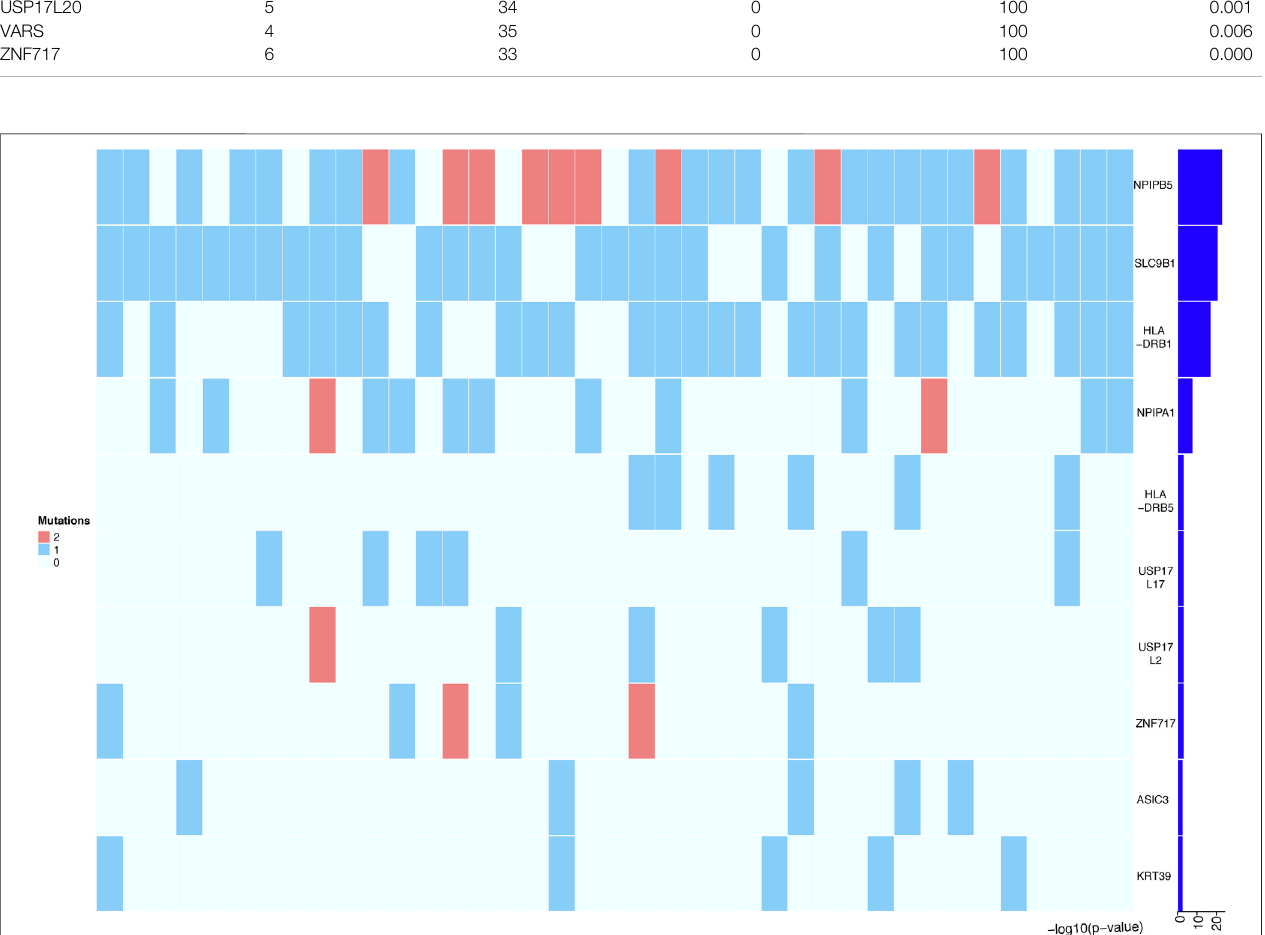
FIGURE 4 | Heatmap representing the top 10 genes identi fi ed in Burden analysis. Heatmap that shows the mutational burden ( p -value < 0.05) of the top 10 gene based on gene-based burden analysis in PDA patients. The heatmap was generated by using R package, the mutation values were normalized per gene over all PDA samples. Each box in the heatmap represent a single variant in a case, with the dark red indicating high gene mutation ration in gene-based Burden analysis.